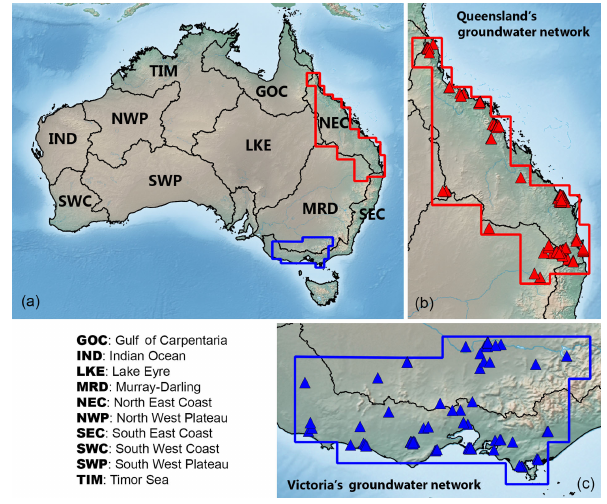
Figure 1. (a) Geographical location of 10 Australian river basins. Red and blue polygons indicate the boundaries of the groundwater networks in Queensland (b) and Victoria (c) , respectively. Triangles (in b and c ) represent the selected bore locations used in this